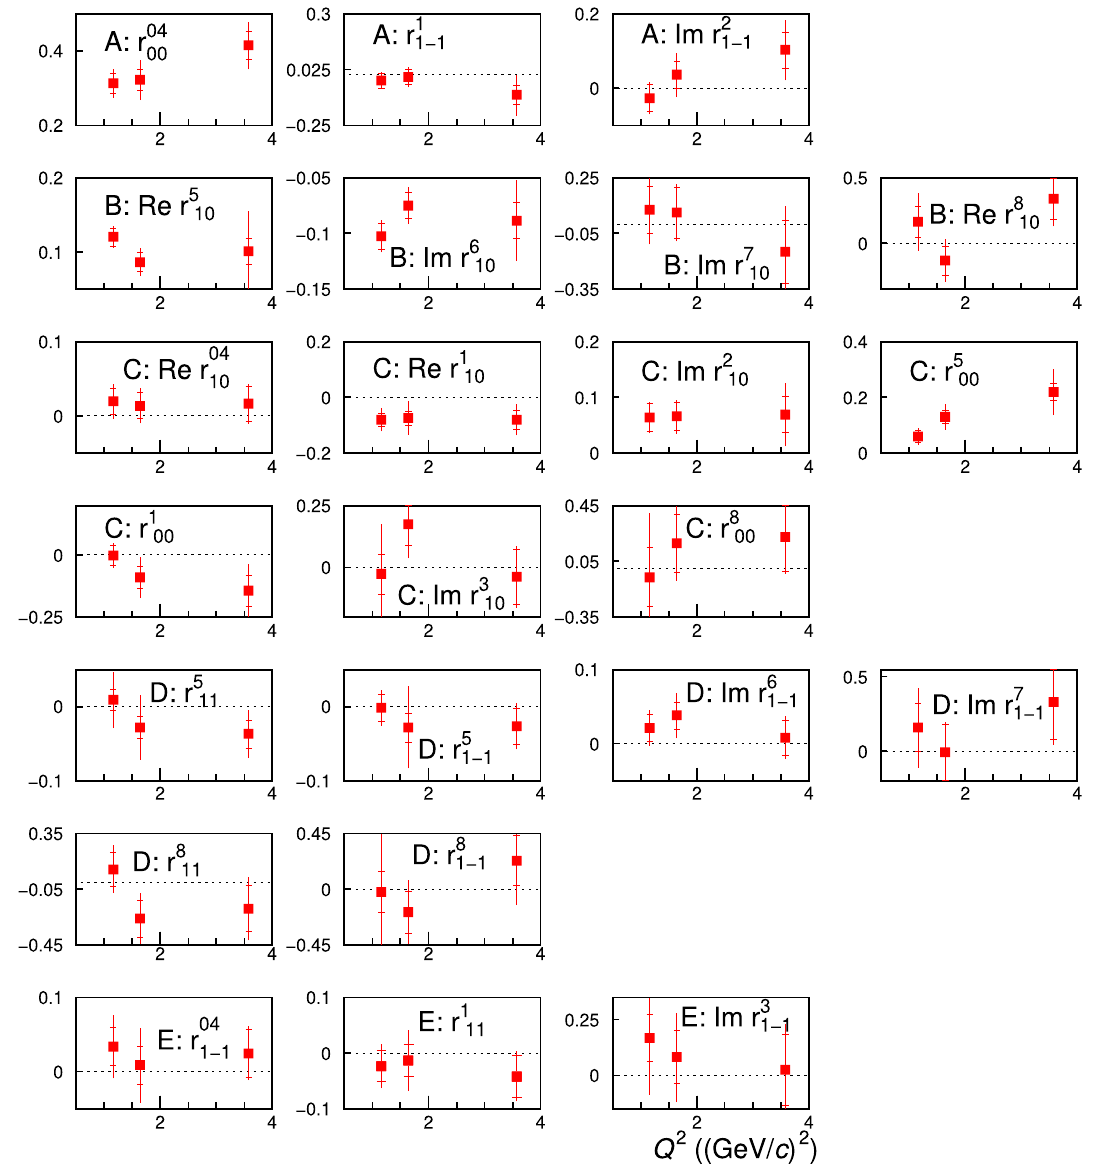
Fig. 6 Q 2 dependence of the measured 23 SDMEs. The capital letters A to E denote the class, to which the SDME belongs. Inner error bars represent statistical uncertainties and outer ones statistical and systematic uncertainties added in quadrature } + Im { r 6 } = 0 . 014 ± 0 . 011 ± 0 . 013 , Re { r 5 10 10 } − Re { r 8 } = − 0 . 088 ± 0 . 110 ± 0 . 196 Im { r 7 10 10